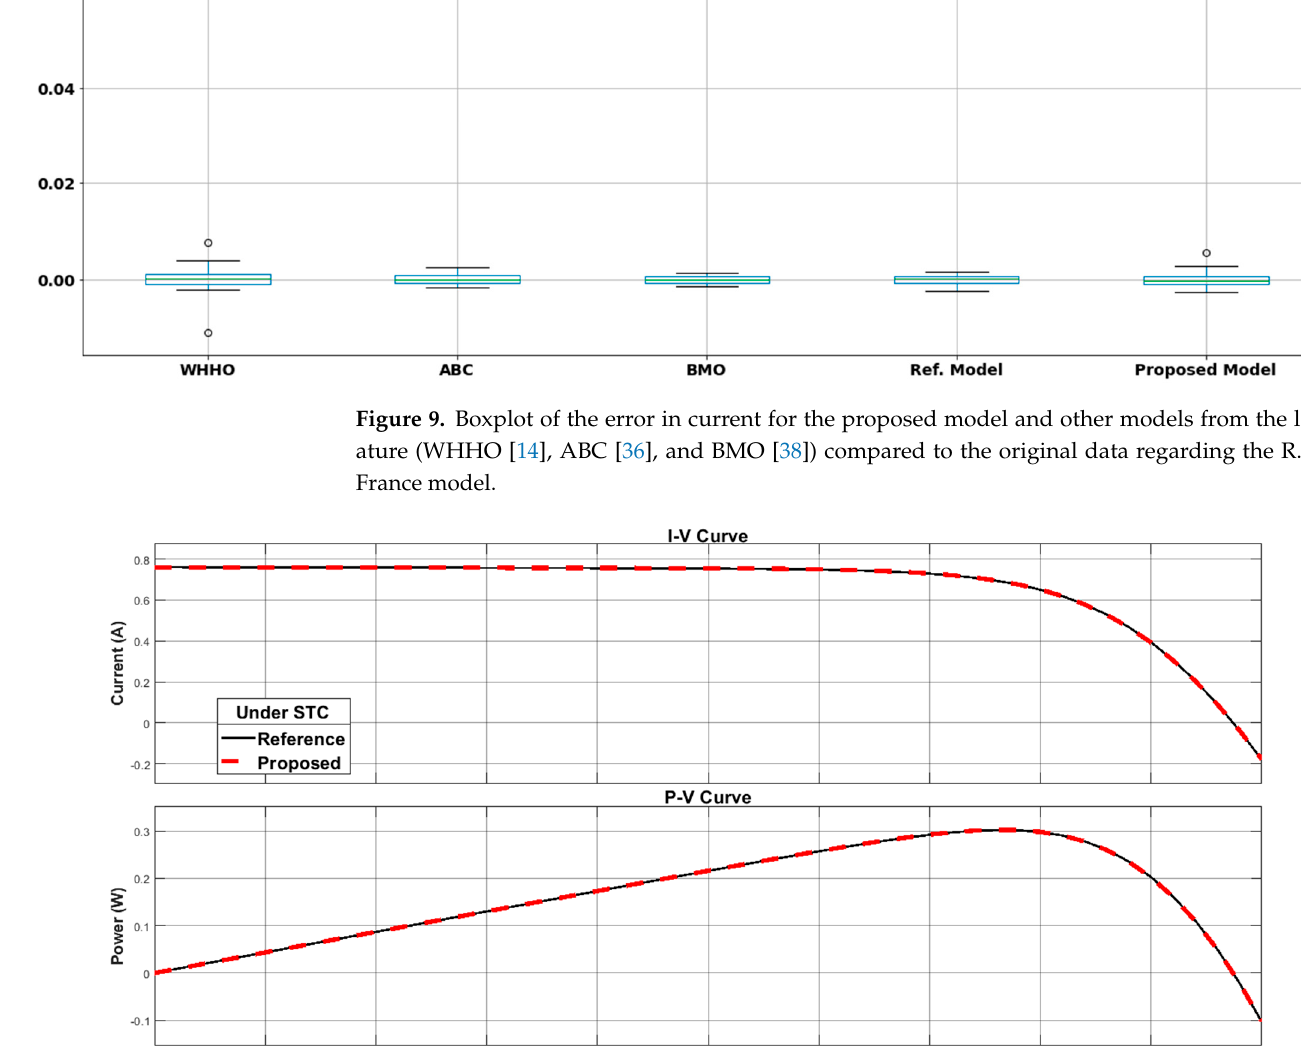
Figure 10. I − V and P − V curves for the reference and the proposed model under STC.